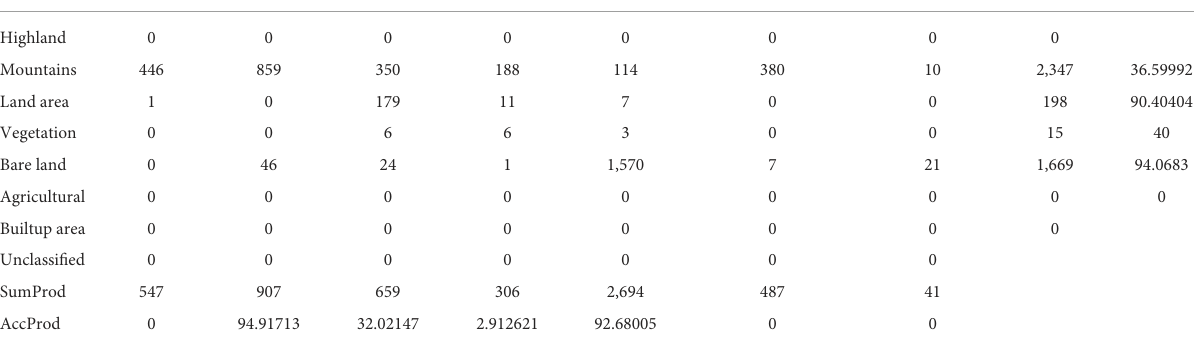
TABLE 7 Confusion matrix for (ANN_RF) proposed work method of Sentinel-2A satellite 2016.